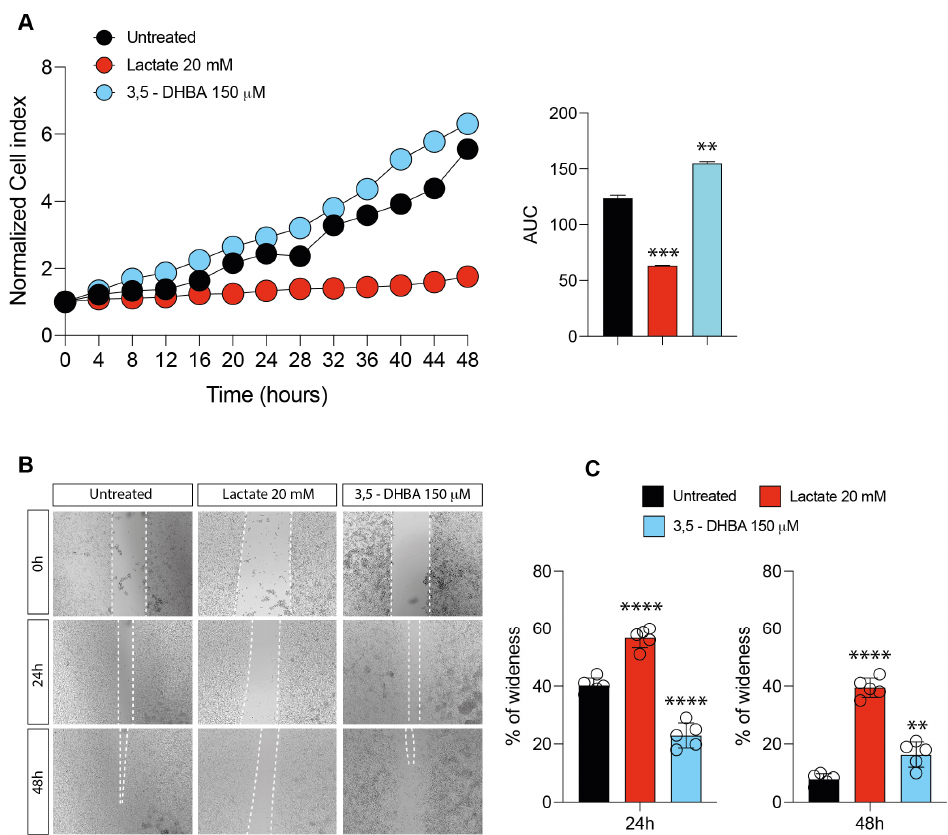
Figure 1. Effect of lactate and 3,5-dihydroxybenzoic acid (3,5-DHBA) on uveal melanoma cell proliferation and migration. ( A ) Real-time cell proliferation monitoring in 92.1 cells, using the xCELLigence system following treatments with lactate (20 mM) and 3,5-DHBA (150 μ M). The cell index values were normalized at the time of pharmacological treatments in order to obtain a normalized cell index. Each dot expresses the average of four different experiments and the area under curve (AUC) is also reported. ( B , C ) Representative micrograph ( B ) and quantification ( C ) of human uveal melanoma cell migration analysis with the wound-healing assay following treatments with lactate (20 mM) and 3,5-DHBA (150 mM). Data are mean of five independent experiments ± SD (one-way ANOVA). ** p < 0.01; *** p < 0.001; **** p < 0.0001.